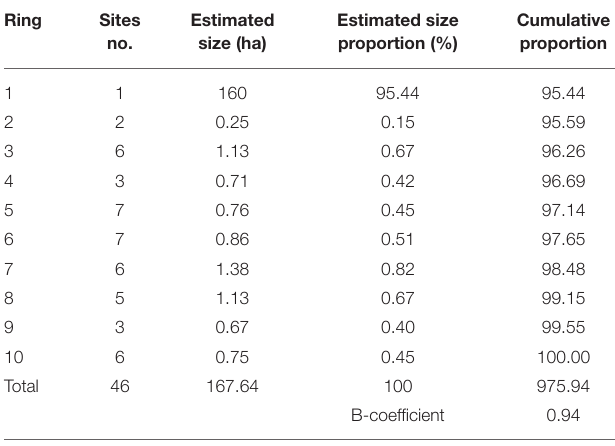
TABLE 8 | Calculation of B-coefficient for Cerveteri in the Post-Archaic period. Ring Sites Estimated Estimated size no. size (ha) proportion (%)